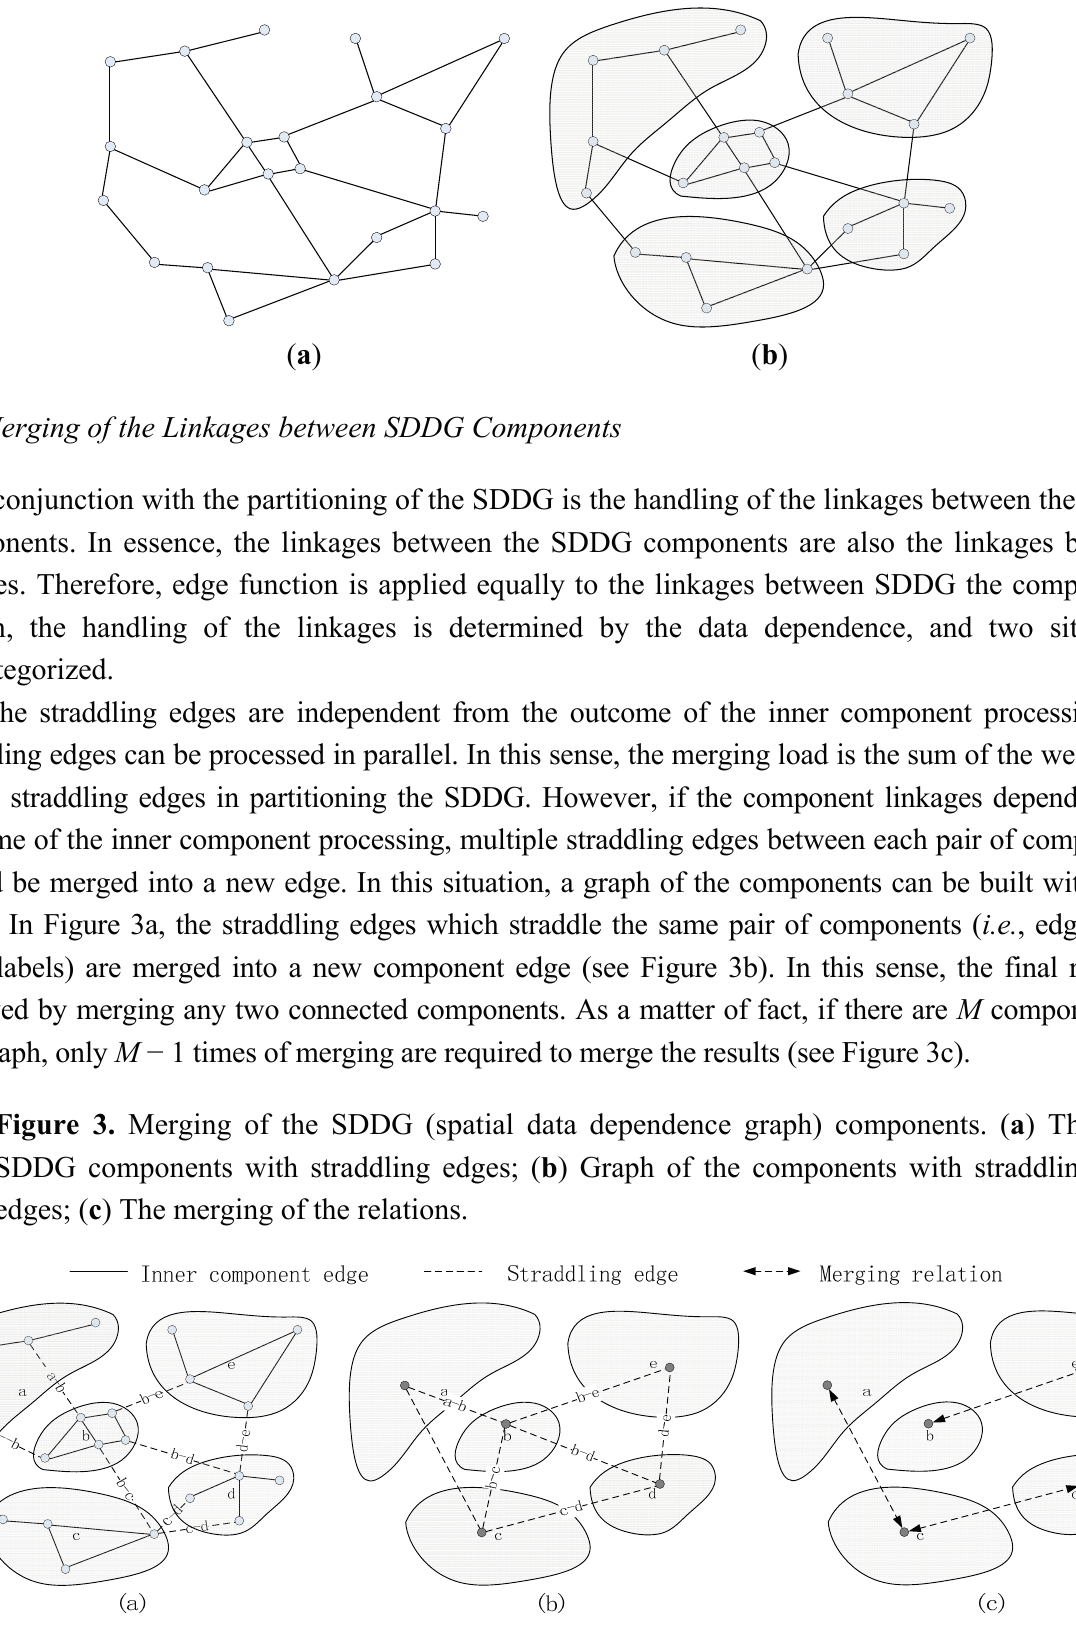
Figure 2. Partition of the SDDG (spatial data dependence graph). ( a ) The SDDG from representation; ( b ) The SDDG components after partitioning.